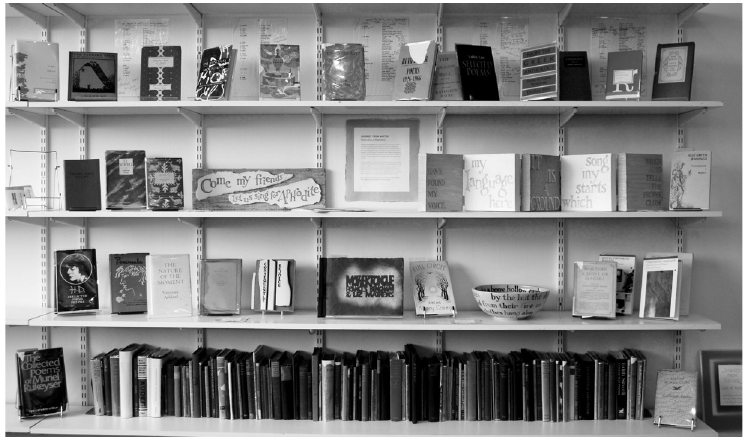
Figure 2 Books from the Ackland Bequest on display in the NPL during Liz Mathews’ artist’s residency at the Southbank Centre in 2008. Photograph © 2020 Liz